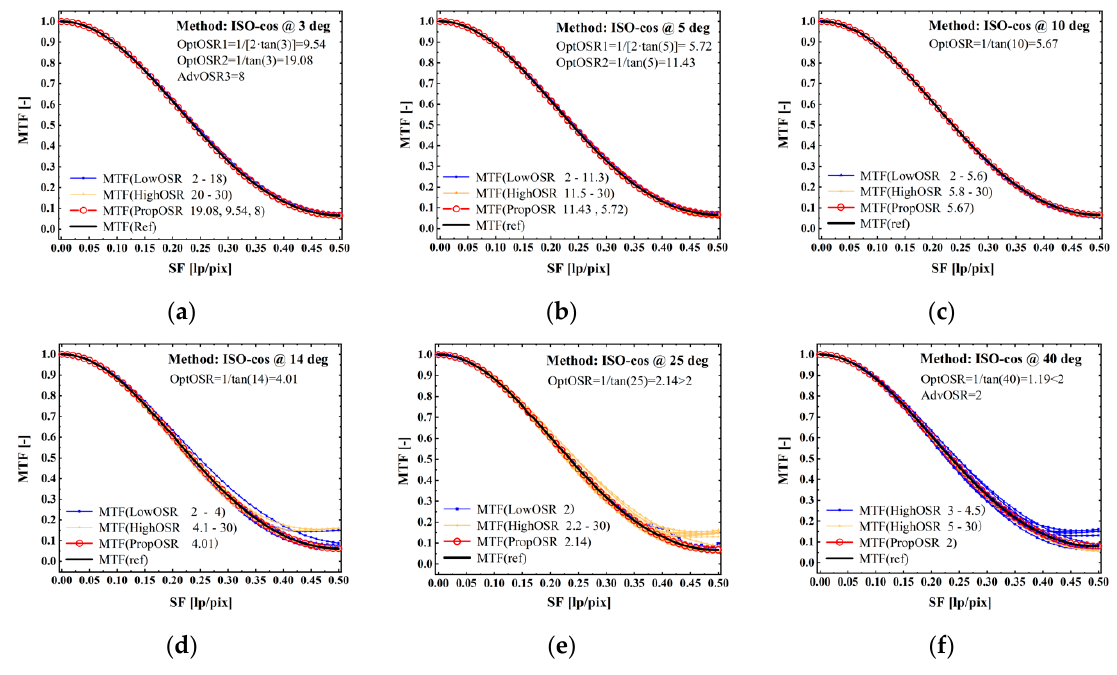
Figure 10. MTF for some tilt angle BDE images when adopting different OSR (ideal optimal, ideal suboptimal, advised, proper, high, and low OSR) using ISO-cos edge method: ( a ) when edge angle is 3 deg, ( b ) when edge angle is 5 deg, ( c ) when edge angle is 10 deg, ( d ) when edge angle is 14 deg, ( e ) when edge angle is 25 deg, ( f ) when edge angle is 40